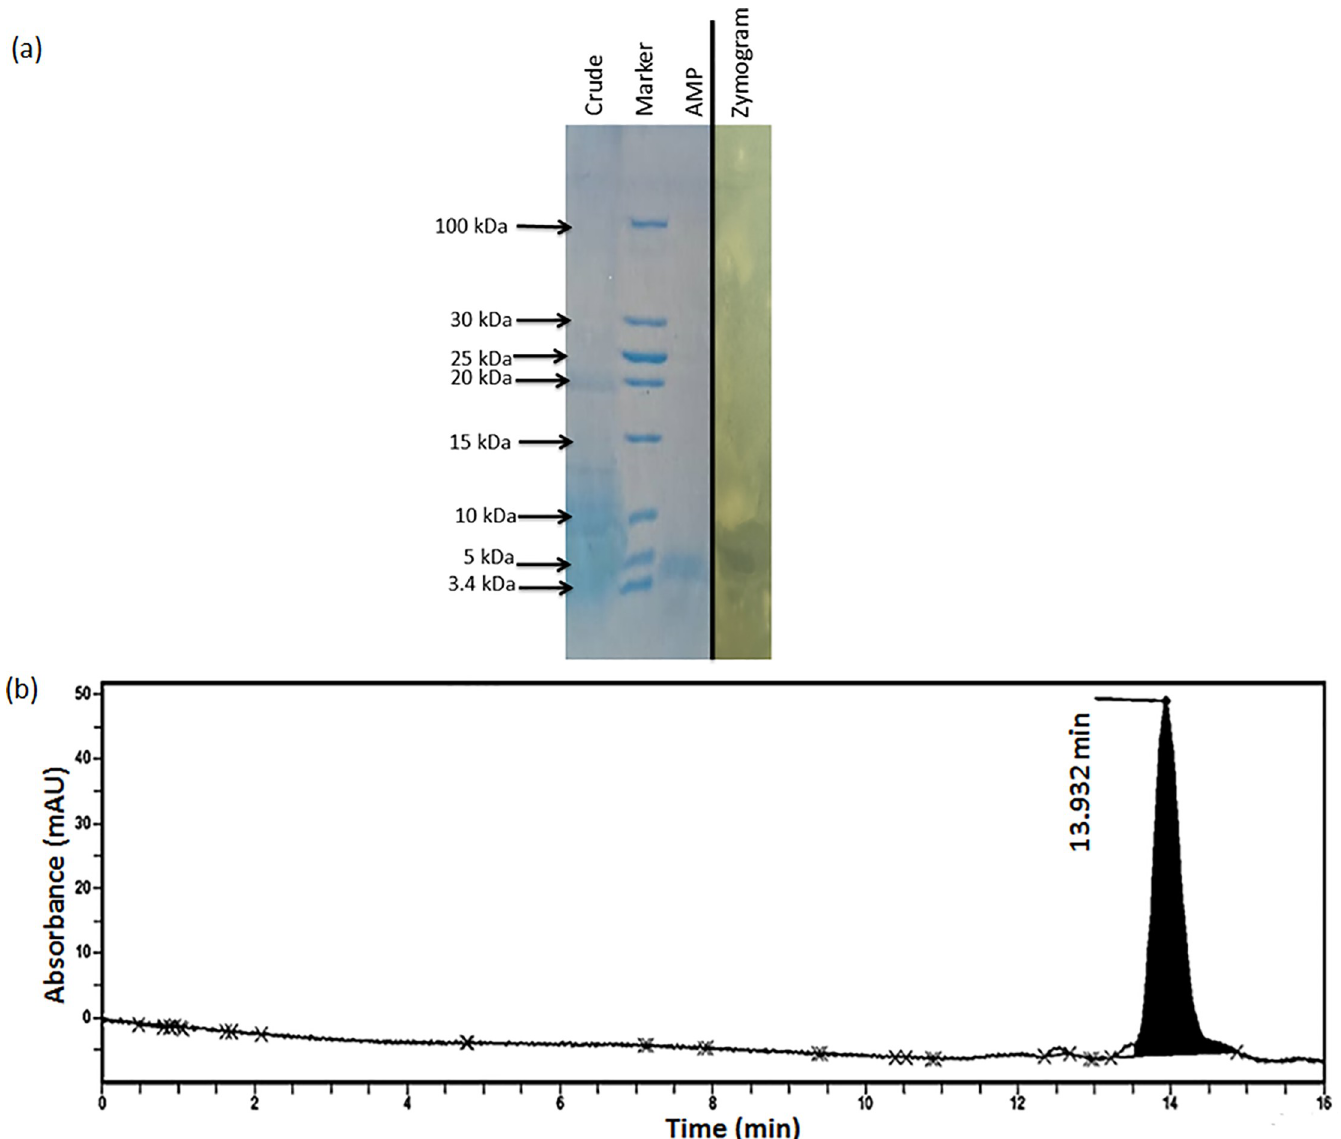
Fig 6. Analysis of silica gel purified Bacillus velezesis PD9 antimicrobial peptide using tricine SDS-PAGE and HPLC. A) Tricine–SDS-PAGE analysis and direct detection of antimicrobial activity of the antimicrobial peptide using zymogram. The single band of purified peptide observed on SDS-PAGE with a halo zone observed against MRSA ATCC 33742 on the zymogram after 24 h of incubation. Vertical black lines in between the AMP and zymogram represents different gels (S1 and S2 Figs) merged together to show the direct inhibitory activity of AMP against MRSA ATCC 33742. Marker: Unstained low range protein ladder. AMP: Antimicrobial peptide. (B) HPLC analysis of the antimicrobial peptide. A single peak was observed on the chromatogram indicating the purity of the silica gel purified antimicrobial peptide indicating successful purification of the antimicrobial peptide.